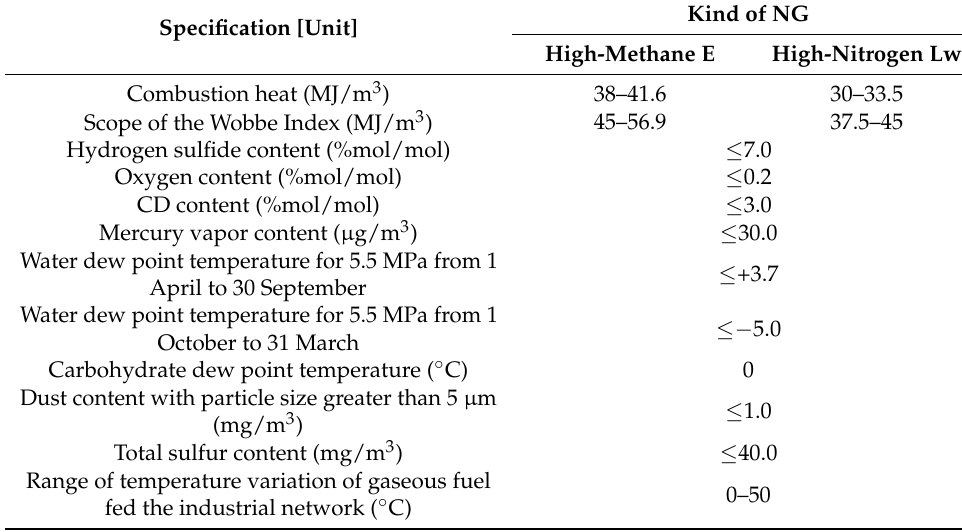
Table 2. Parameters of natural gas (NG) in the gas grid [46].